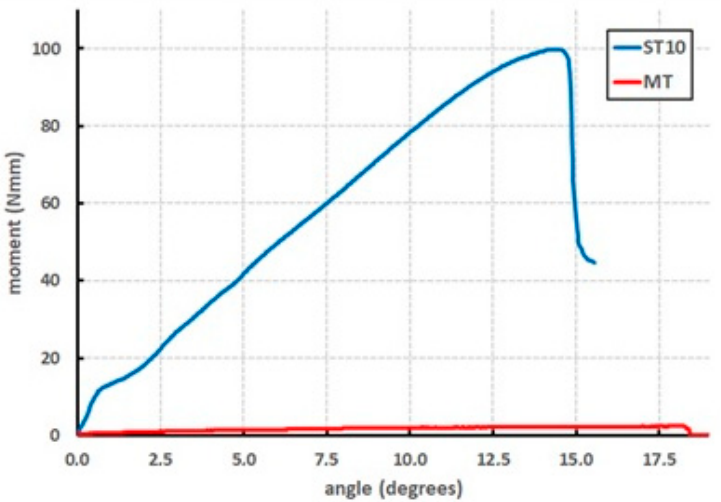
Figure 4. Two examples of moment/angle test curves. Blue: steel tie (0.010 inch) (ST10), featuring among the highest stiffness and maximal moment values. Red: modified tipping tie (MT), featuring among the lowest stiffness and maximal moment values.